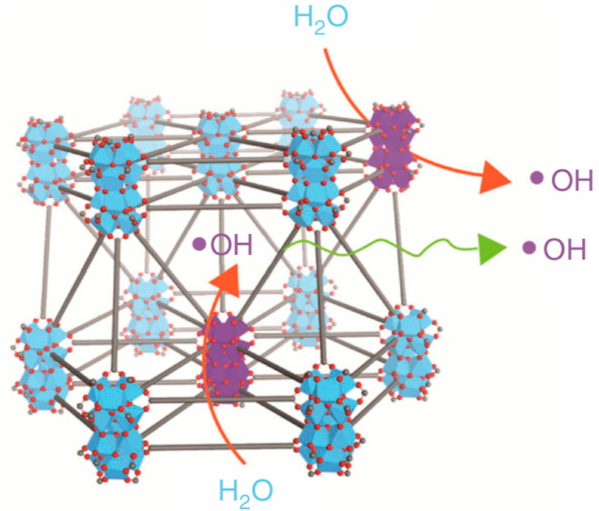
Figure 4. Representation of hydroxyl radical (ROS) generation upon X-ray irradiation and di ff